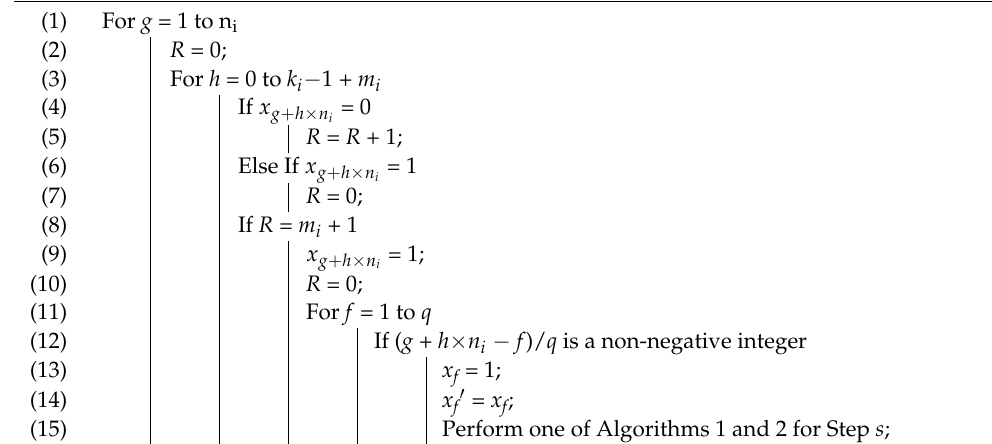
Algorithm 4: Individual modification for the case with d i = 1 and m i + 1 < k